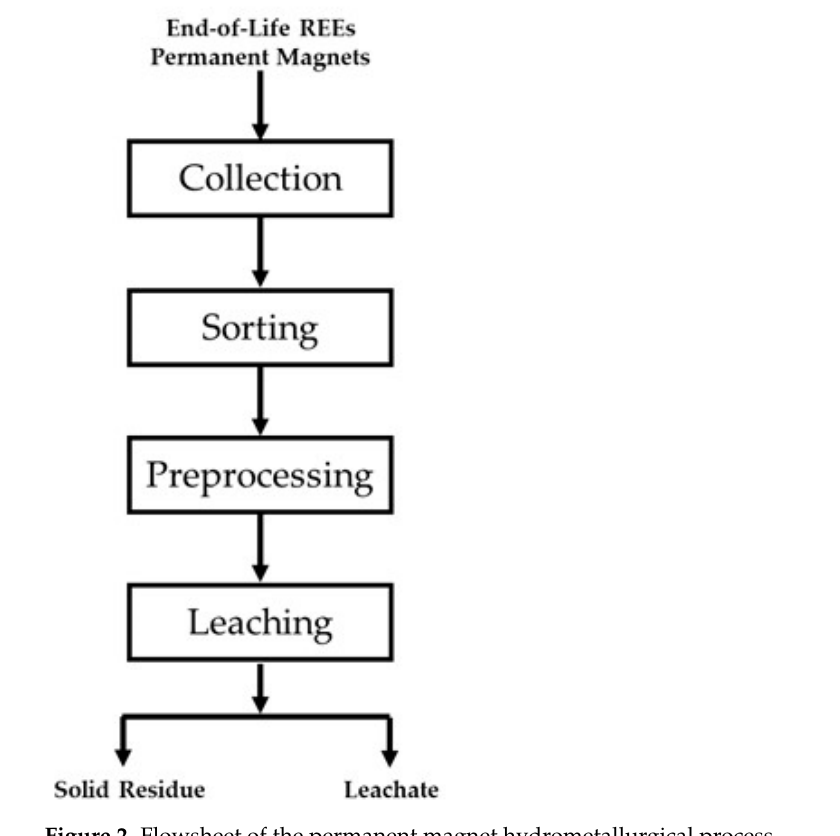
Figure 2. Flowsheet of the permanent magnet hydrometallurgical process.